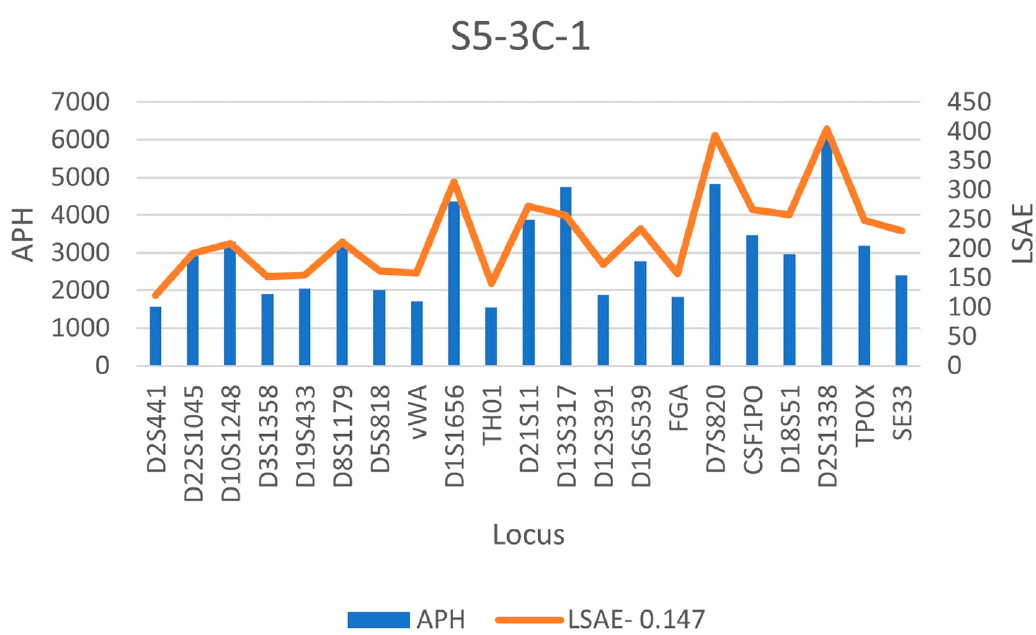
Figure 7. DSCS (3 cell subsample) inter-locus peak height variance.